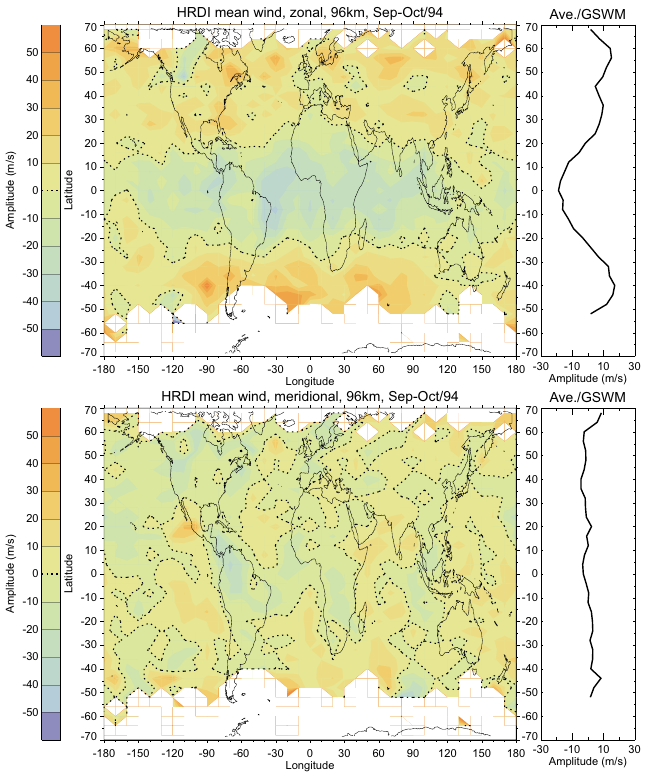
Fig. 13. Mean winds at 96km for September–October